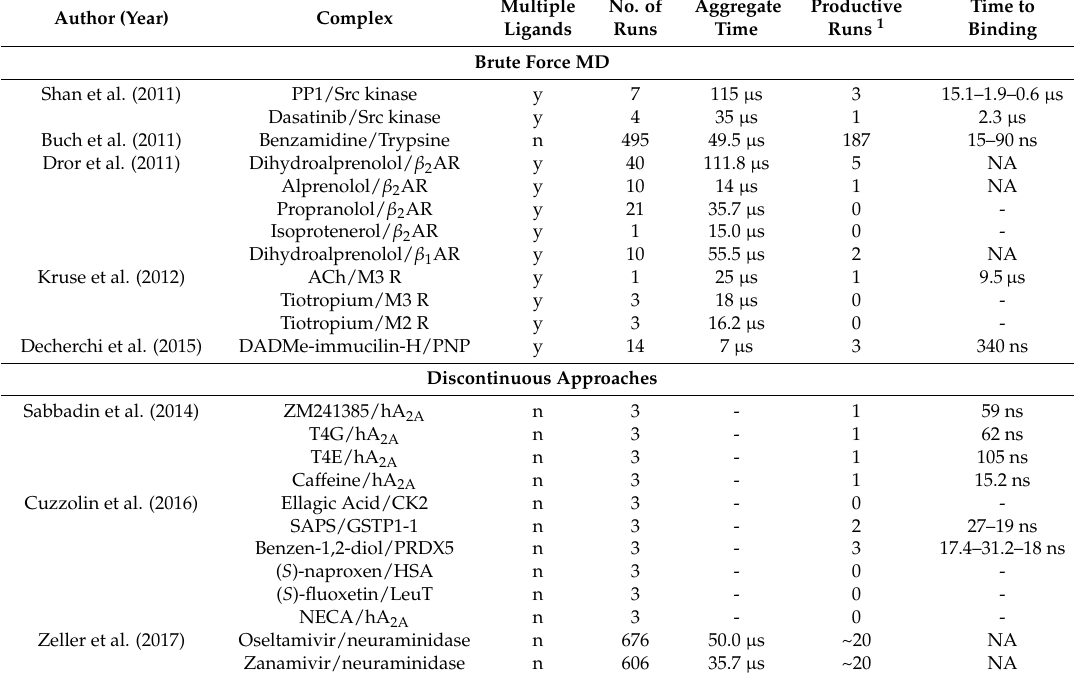
Table 2. Comparative time scales of brute force MD versus discontinuous approaches as reported in retrospective studies. Owing to the inherent difficulties in comparing timescales of several short trajectories, adaptive sampling is not considered in this